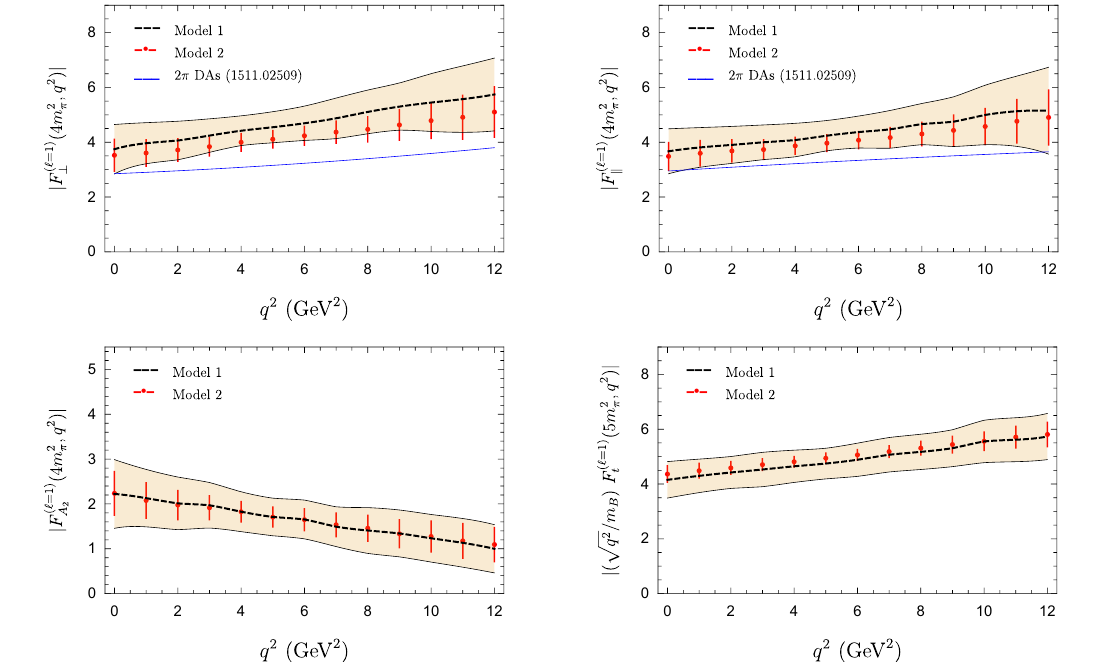
Figure 3 . B ! (cid:25)(cid:25) form factors as a function of the momentum transfer q 2 at the dipion threshold s = 4 m 2 ( F t is plotted instead at s = 5 m 2 ). The models of table 2 (Model 1) and table 3 (Model 2) (cid:25) (cid:25) are compared to the predictions for F from the LCSRs with dipion DAs given in ref. [8] (only ? ; k central values). Shaded regions and error bars account for all